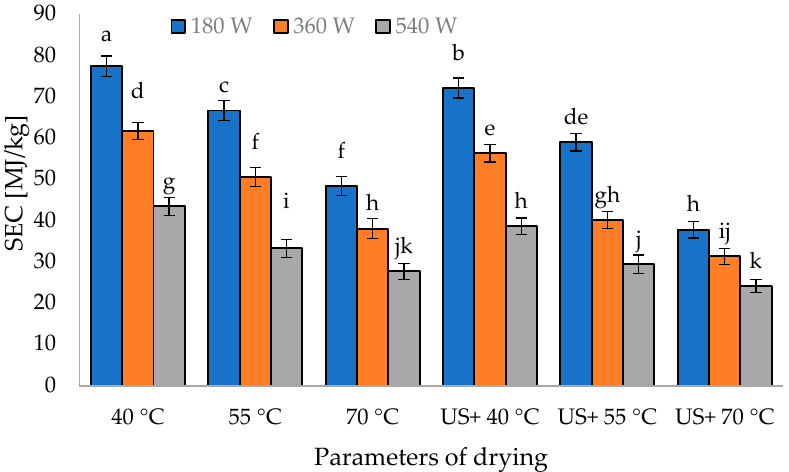
Figure 2. Specific energy consumption during different drying schemes. Data followed by different letters (a–k) in each column are significantly different at p < 0.01. Columns with the same letters are not significantly different.